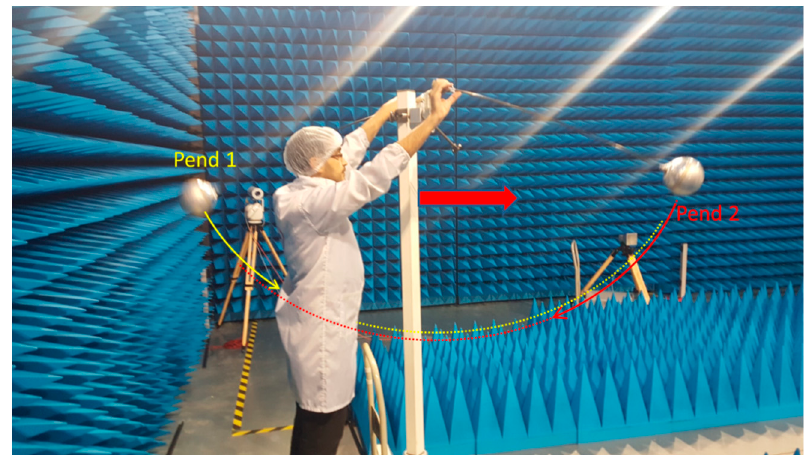
Figure 20. Two pendulums swinging simultaneously opposite to each other on a moving trolley.